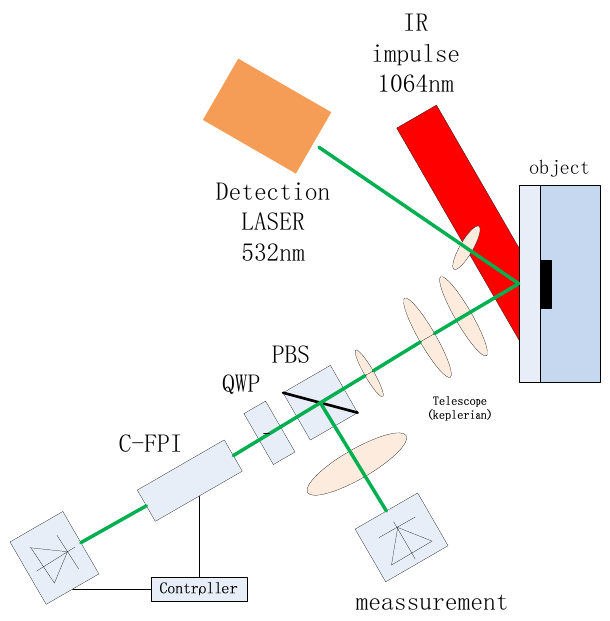
Figure 27. Schematic setup of the remote photoacoustic system.